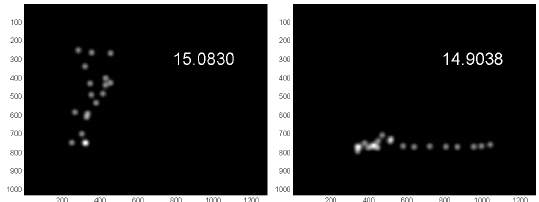
Figure 2: Two Fixation density maps (FDMs) of a single subject s observing a web page w during the first six seconds of presentation (left side) and the following six seconds (right side). Corresponding entropy values are depicted. The data matrix constituting a FDM is the input of the entropy formulae (1). Higher entropy values indicate a more spread out fixation distribution (left side) independent of geometrical arrangements. Absolute entropy values are negligible since they depend on image resolution and the size of the Gaussian kernel